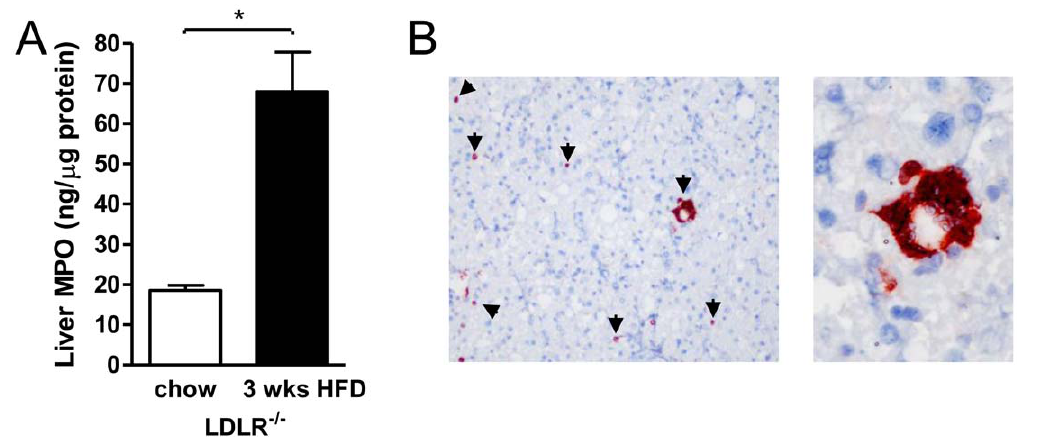
Figure 1. Strong high-fat diet-induced induction of MPO in the liver. A) Total liver MPO content of LDLR 2 / 2 mice as assessed by ELISA was almost four-fold increased by three weeks of high-fat feeding (19 6 1 vs. 68 6 10 ng/ m g protein, p , 0.01; n=6 in both groups). B) MPO immunostaining reveals infiltration of neutrophils into the liver of LDLR 2 / 2 mice after three weeks of high-fat feeding (see arrows; 100 6 magnification). Many neutrophils are organized into aggregates predominantly surrounding steatotic hepatocytes (right panel; 200 6 magnification). MPO was not detected in Kupffer cells.